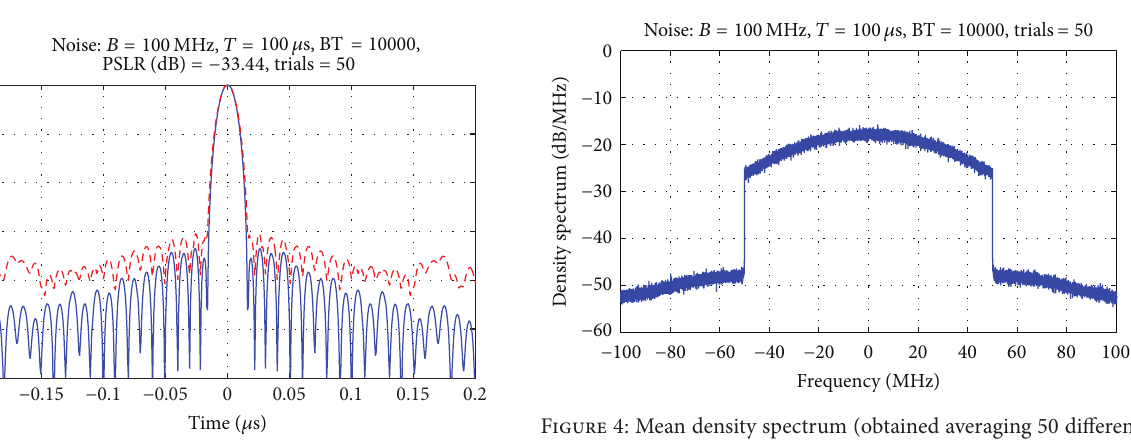
Figure 4: Mean density spectrum (obtained averaging 50 different spectra) for a pair of phase noise signals. Compression ratio 10000, considering for ZMNL a hard limiter.